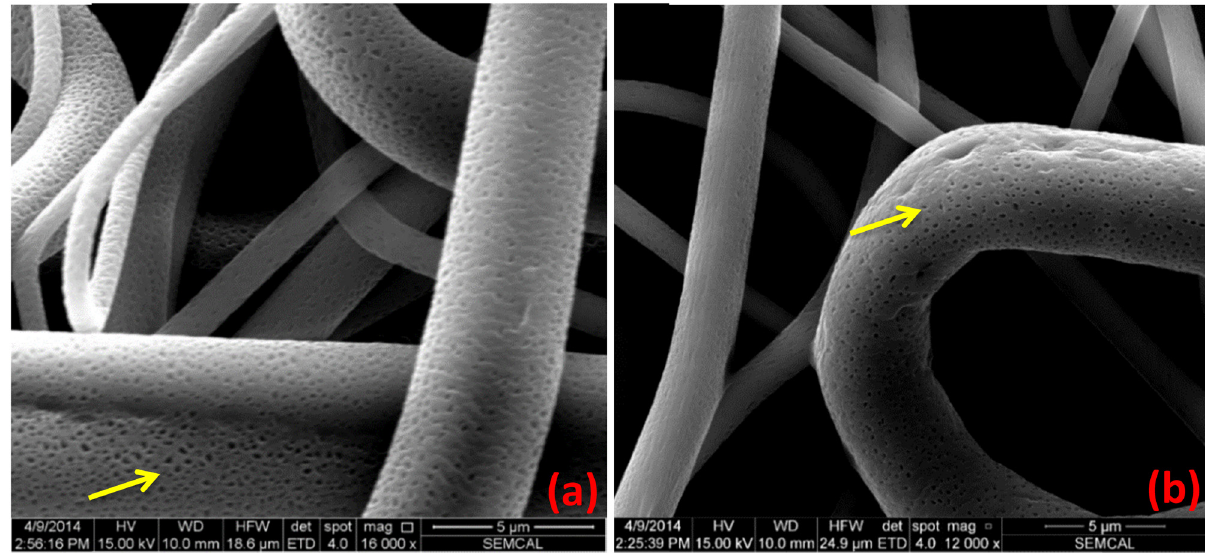
Figure 4: Representative SEM images showing electrospun THV micro fi bers prepared from the THV/ethyl acetate solution with the concentration of 15 wt%; 15 cm_11 gauge_19 kV, sample 3 as listed in Tables 1 and 2 ( a ) and 15 cm_16 gauge_19 kV, sample 4 as listed in Tables 1 and 2 ( b ) . Yellow arrows show the